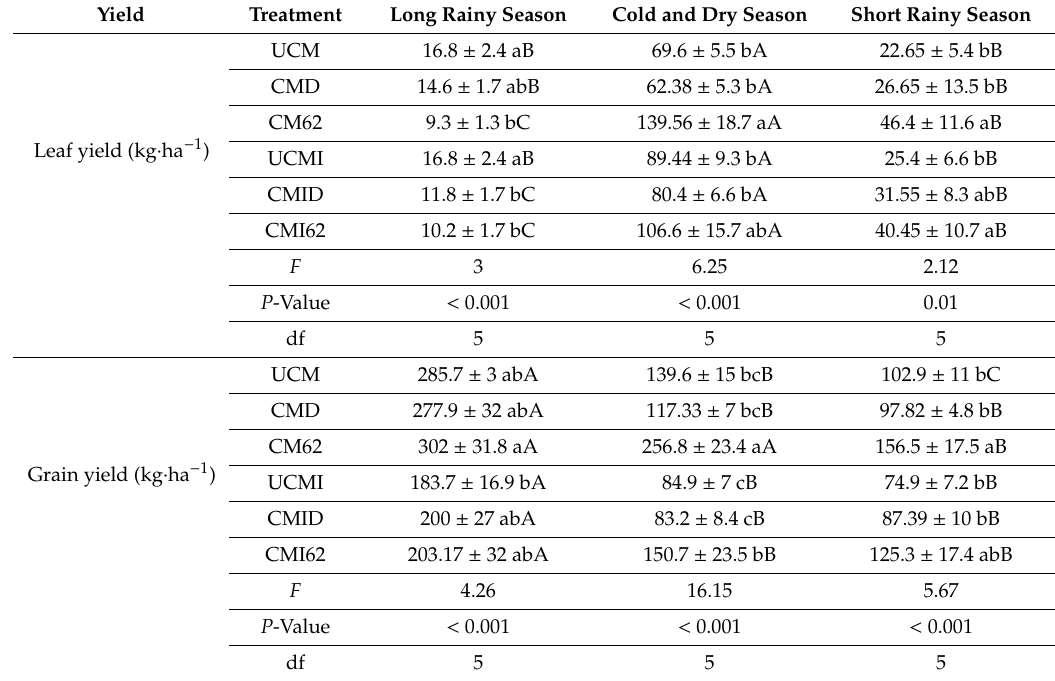
Table 3. Cowpea leaf and grain yield (kg / ha) as influenced by the di ff erent treatments during the three seasons. Yield Treatment Long Rainy Season Cold and Dry Season Short Rainy